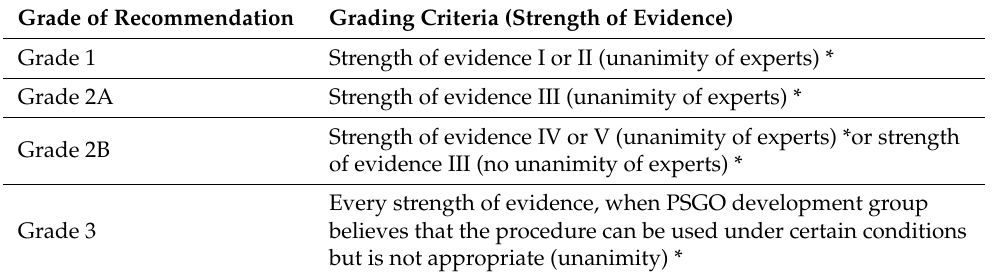
Table 2. Polish Society of Gynaecological Oncology (PSGO) recommendation classification system.